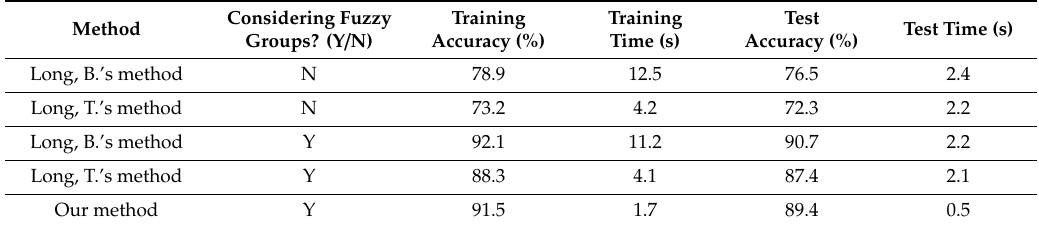
Figure 8. Sketch map of biquad quad-op amp low-pass filter. Table 6. Training and test accuracies of soft fault of Leapfrog circuit.